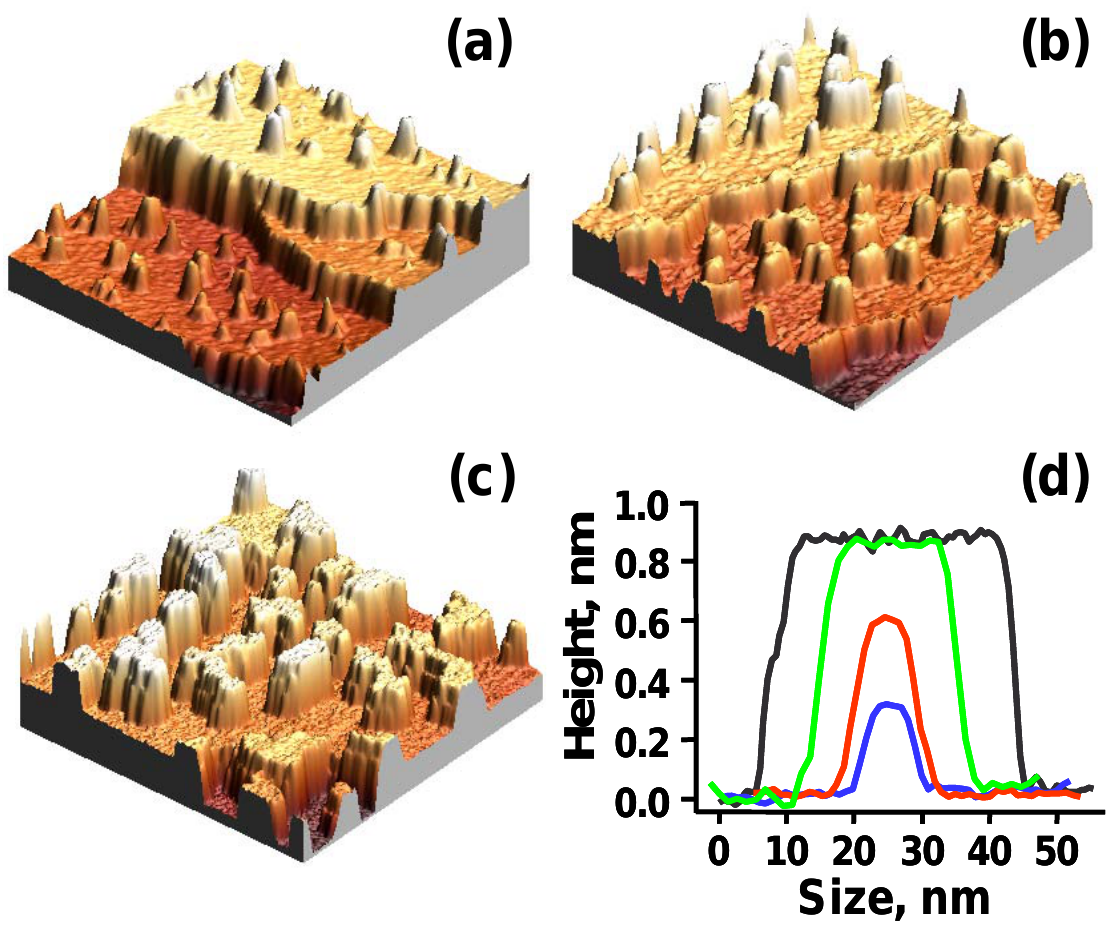
Figure 17. STM images (243 × 243 nm 2 ) for Ag films for (a) 0.26 ML, (b) 0.70 ML, and (c) 1.0 ML. (d) Line profiles from typical individual Ag islands showing the sequence